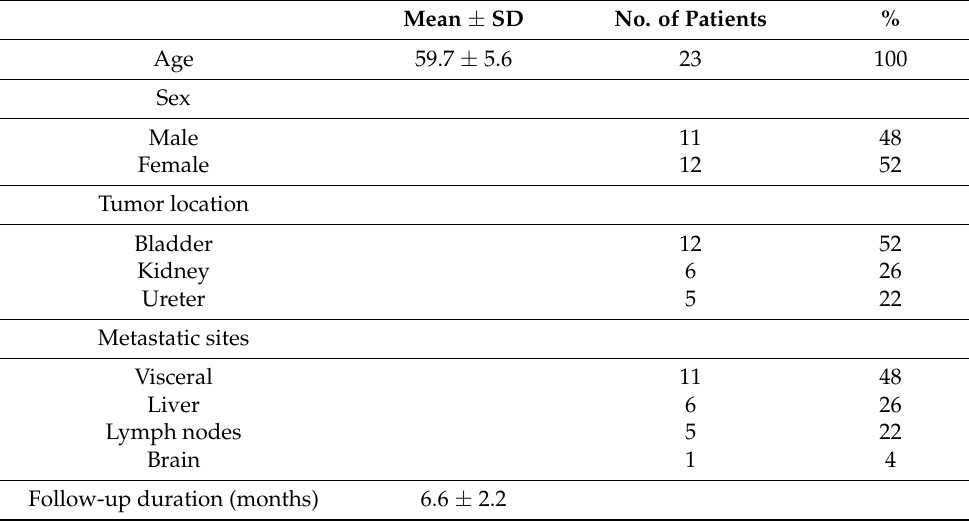
Table 1. Demographic and clinical features of patients with urothelial carcinoma.